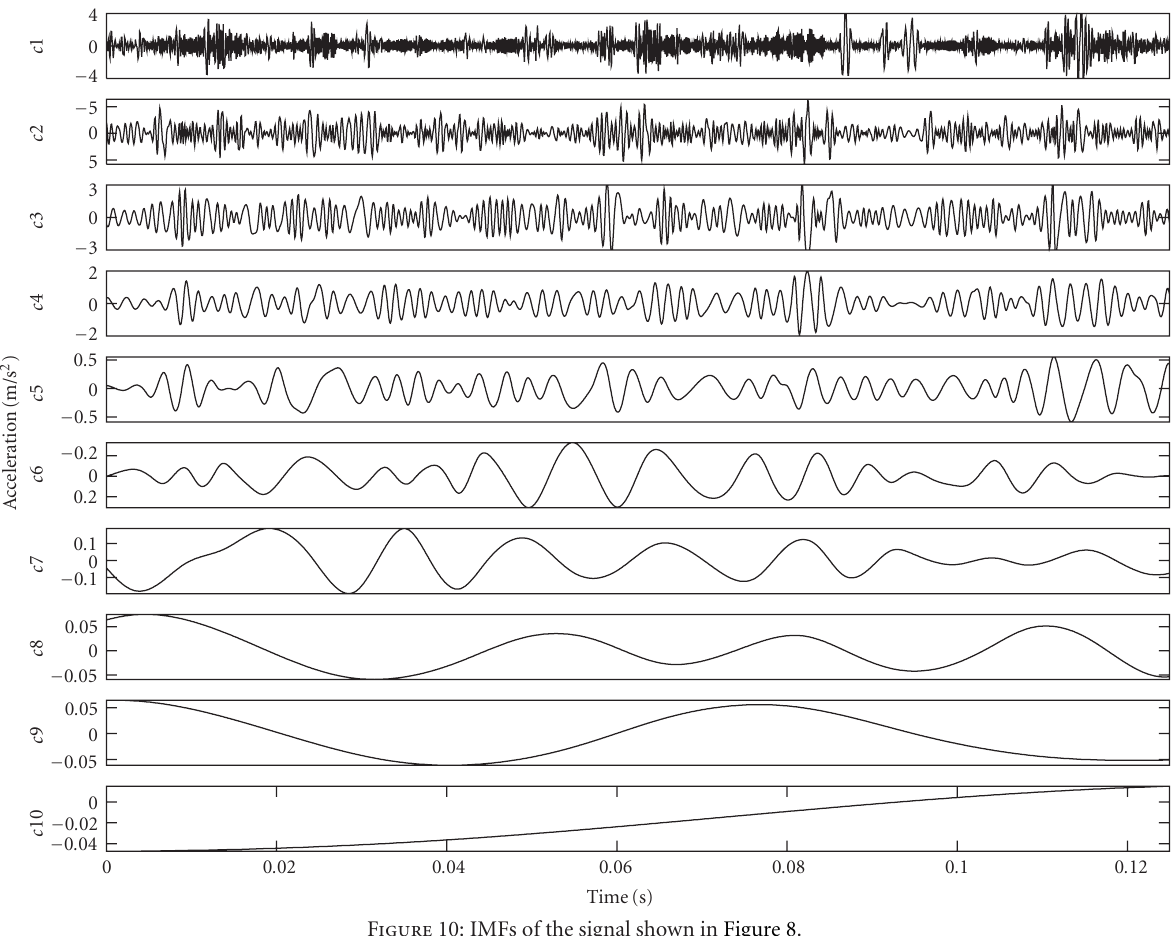
Figure 10: IMFs of the signal shown in Figure 8.